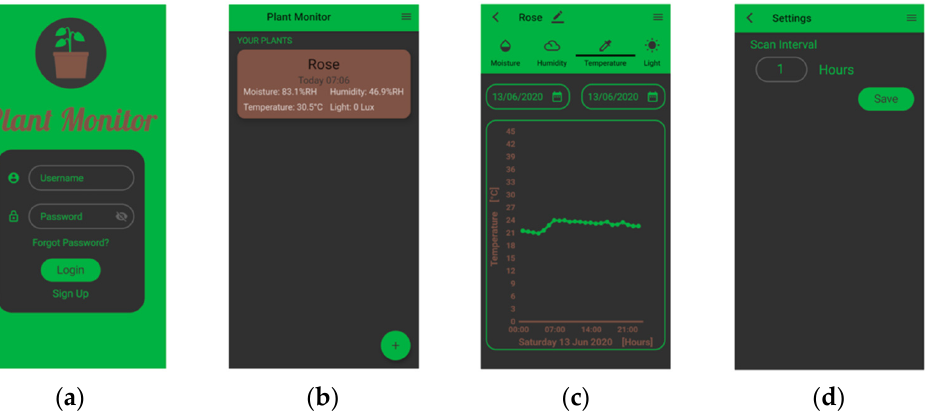
Figure 11. The plant monitoring app: ( a ) login page; ( b ) report on the monitored plants; ( c ) temper- ature graph over time; ( d ) scan interval settings.